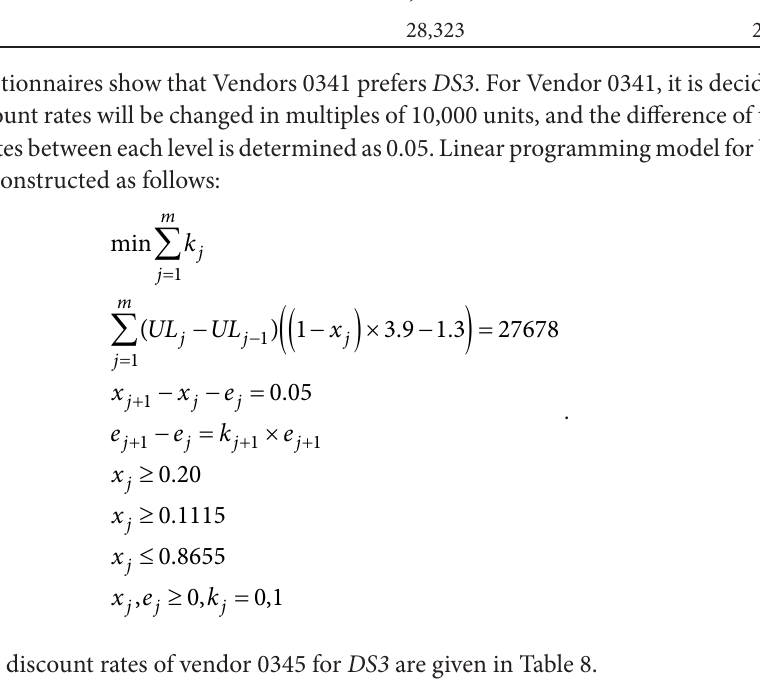
Table 8. Upper levels of the intervals and final discount rates of vendor 0341 for DS3 j UL